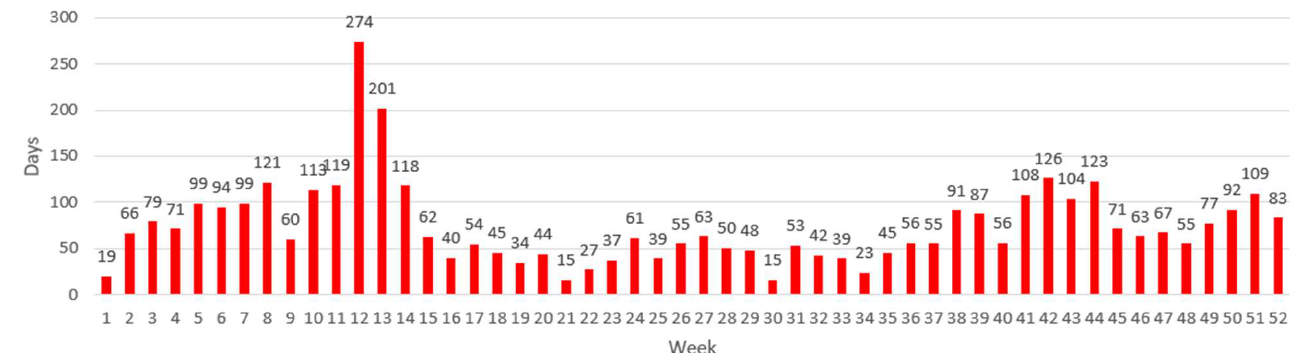
Figure 2. Weekly absences for company 2 in 2020, Showing an increase starting from week 12, which was the beginning of the COVID-19 pandemic in Belgium, and this rise continued, marking the first COVID wave. The rest of the year was more stable, although a small rise can be observed starting from week 41, marking the second wave of COVID infections in